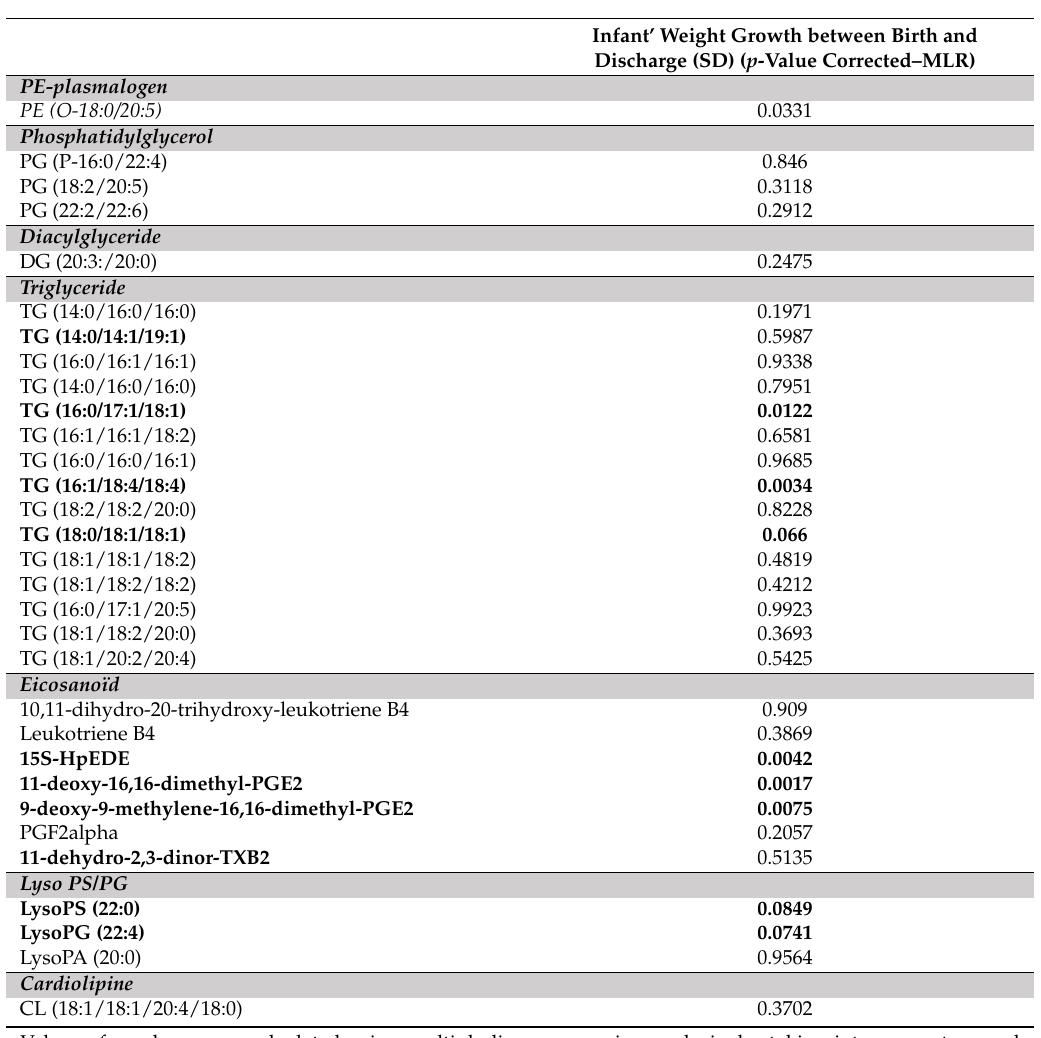
Table 4. Cont. Infant’ Weight Growth between Birth and Discharge (SD) ( p -Value